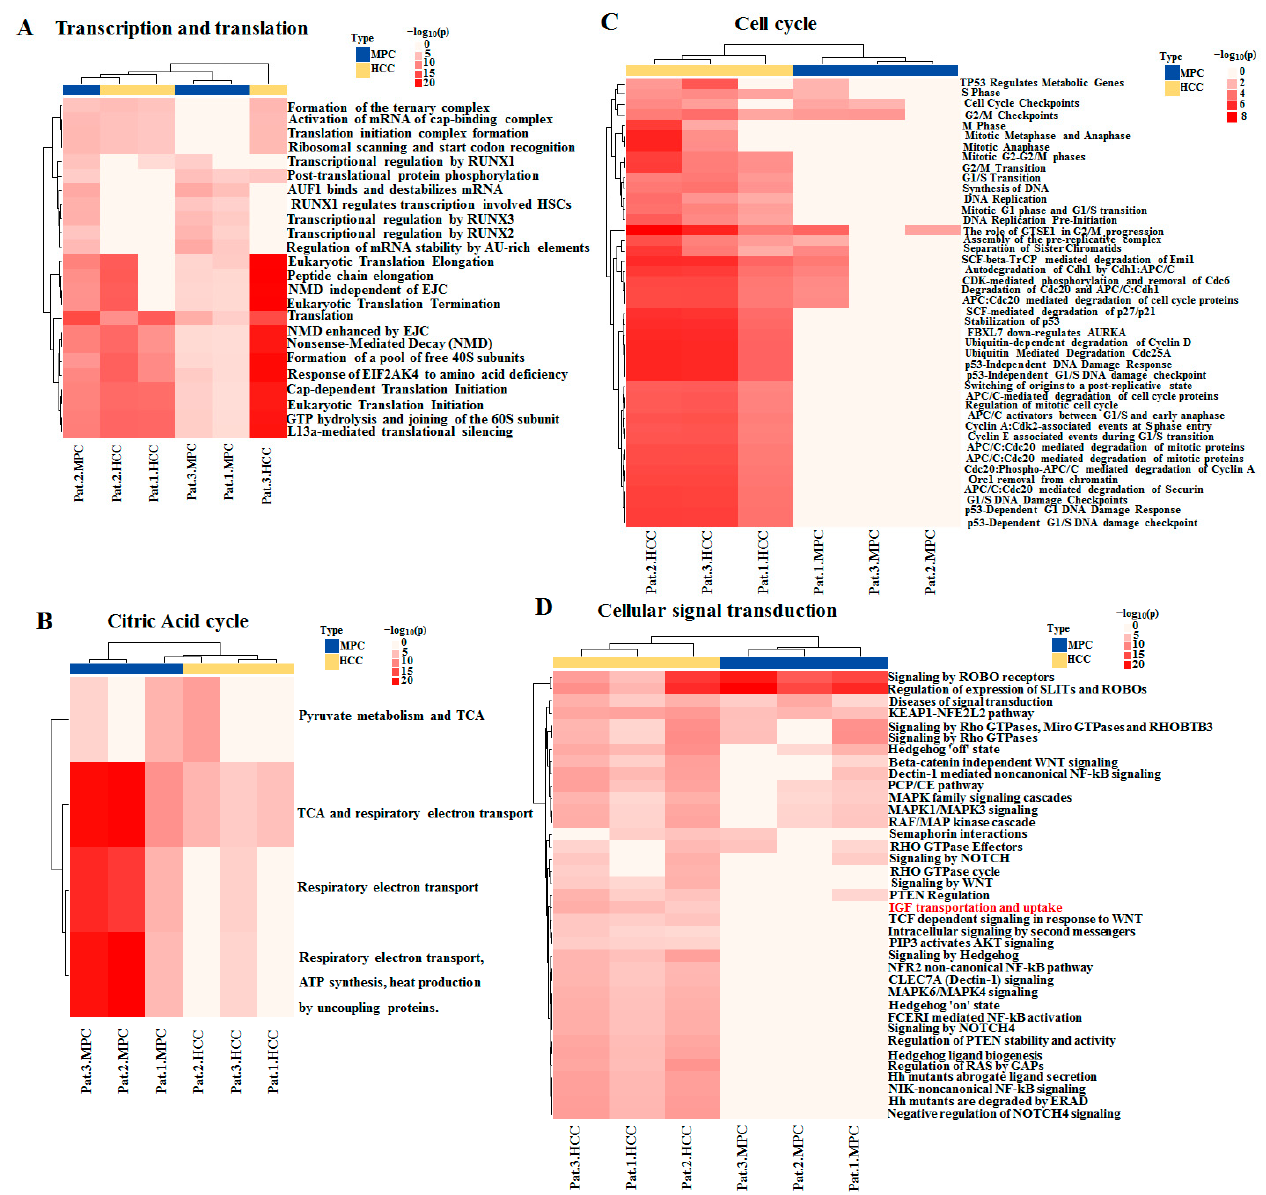
Figure 4. Heatmap showing enrichment pathways involving AHNAK protein in HCC and MPC tissues: ( A ) Transcription and translation. ( B ) Citric acid cycle. ( C ) Cell cycle; ( D ) Cellular signal transduction. Red text indicating enriched pathway: “IGF uptake and transportation”. MPC, matched paracancerous.